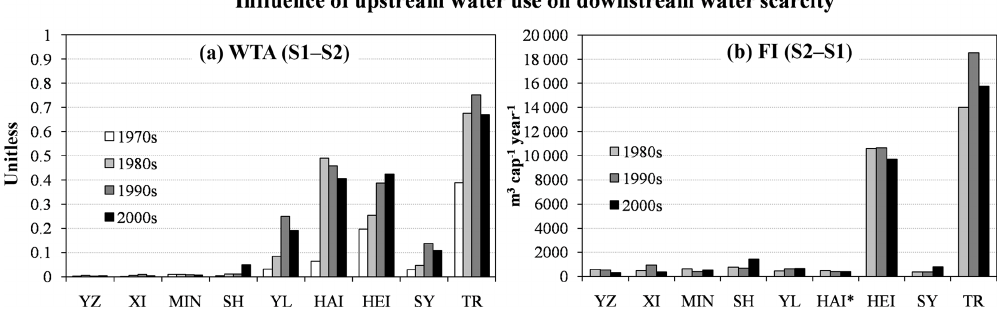
Figure 6. Quantitative impact of upstream water use on downstream WTA (a) and FI (b) . S1 is a scenario in which downstream WTA (FI) is contributed to by upstream water use while S2 is a scenario in which downstream WTA (FI) is not contributed to by upstream water use. S1–S2 (S2–S1) indicates the difference in stress between the two scenarios. YZ represents Yangtze River basin, XI represents Pearl River basin, MIN represents Min River basin, SH represents Songhua River basin, YL represents Yellow River basin, HAI represents Hai River basin, SY represents Shiyang River basin, HEI represents Hei River basin, and TR represents Tarim River basin. The asterisk symbol indicates that the values are enlarged by 10 times for Hai River basin to make them visible for comparison purposes.